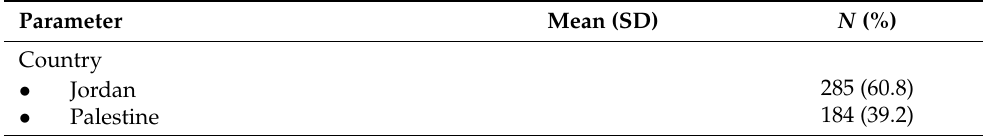
Table 1. Socio-demographic characteristics of the study sample ( N = 469